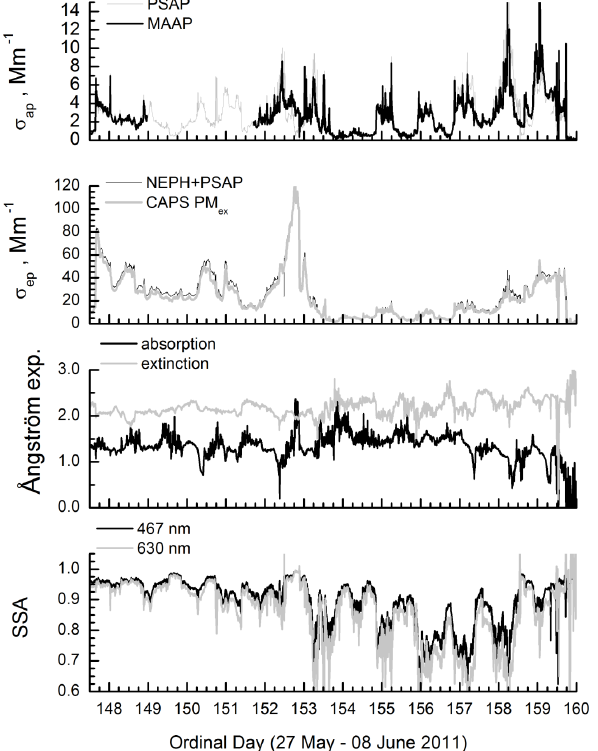
Fig. 9. Time series of aerosol optical properties at λ = 630nm measured for ambient aerosol at Aerodyne Research Inc. premises. Properties are absorption coefficient, σ ap , from MAAP and PSAP; extinction coefficient, σ ep , from CAPS PM ex and NEPH + PSAP; ˚Angstr¨om exponents of extinction and absorption for the wavelength ratio 467/630nm; and single-scattering albedo, SSA, for wavelengths 467 and 630nm.